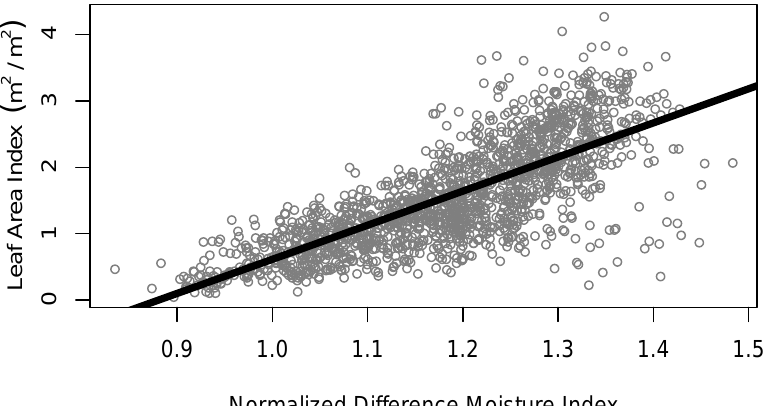
Figure 2. Relationship between the normalized difference moisture index (shifted by one to be in the positive domain) and leaf area index data fit to a simple linear model for all observed measurement points (n = 1673). Adjusted R 2 for this relationship was 0.5837 and root mean square error was